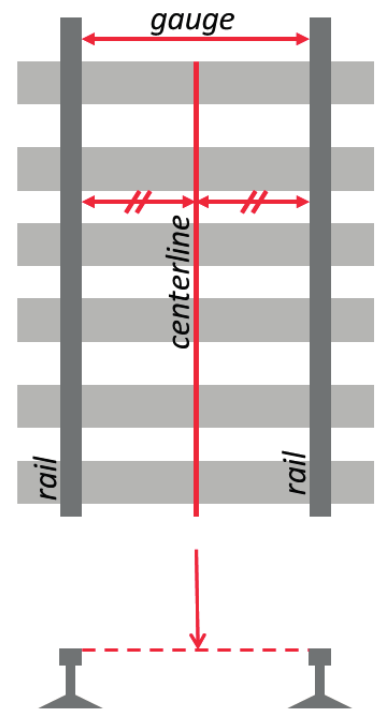
Figure 2. Schematic presentation of centerline, gauge and